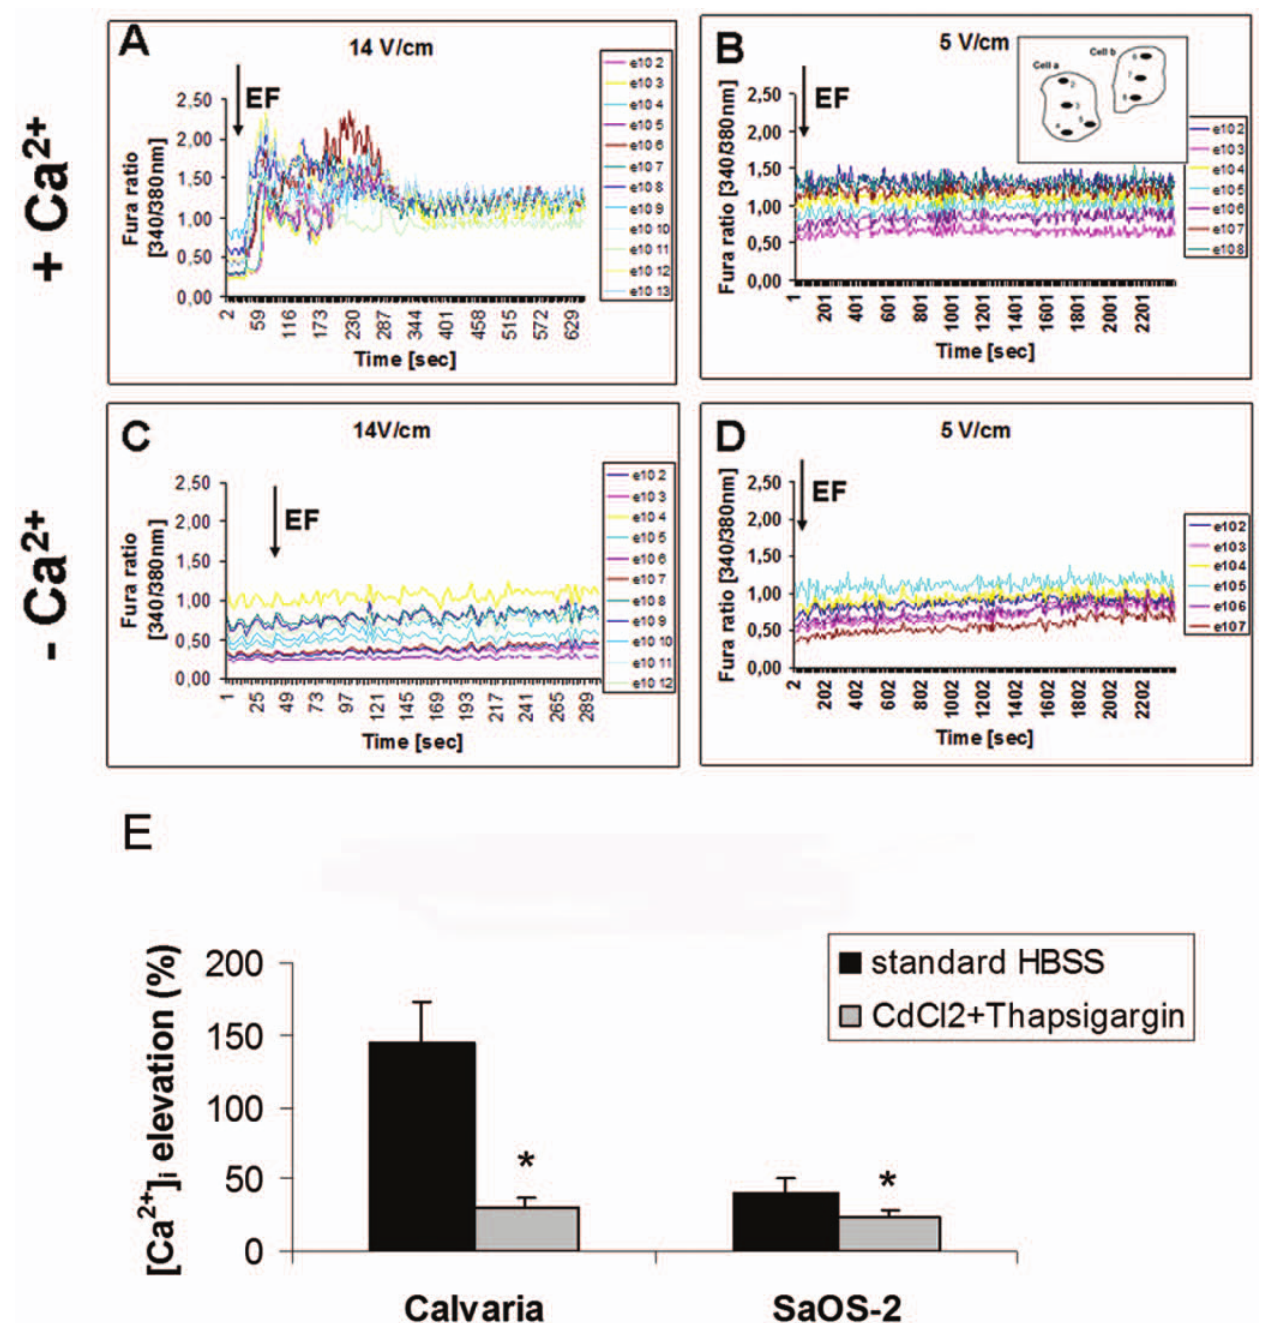
Figure 4. Fura-2AM kinetics showing [Ca 2 + ] i elevation during dcEF-induced migration is dependent on Ca 2 + and EF strength, and involves VGCCs. The dcEF (black arrows) was applied 30 seconds after starting the time-lapse recordings. Elevated and steady state Ca 2 + levels of calvaria cells exposed to strong (14 V/cm) or weak (5 V/cm) of dcEF in the presence of Ca 2 + (A,B). In the absence of Ca 2 + , both strong (C) and weak (D) dcEF failed to stimulate intracellular Ca 2 + . A scheme of two cells with marked ROIs is shown for B. Lines in each graphic correspond to different groups of ROIs from different cells and are listed in the legends. 20–23 cells with similar kinetics were scored from 3–6 individual experiments for each condition. (E) Inhibition of dcEF-induced [Ca 2 + ] i elevation by VGCC blocker CdCl 2 in both calvarial and SaOS-2 osteoblast-like cells. 8 cells from 5 individual experiments were analyzed for each condition. Means and standard deviations are shown. * indicates P , 0.05 vs. the elevation in the normal conditions without the